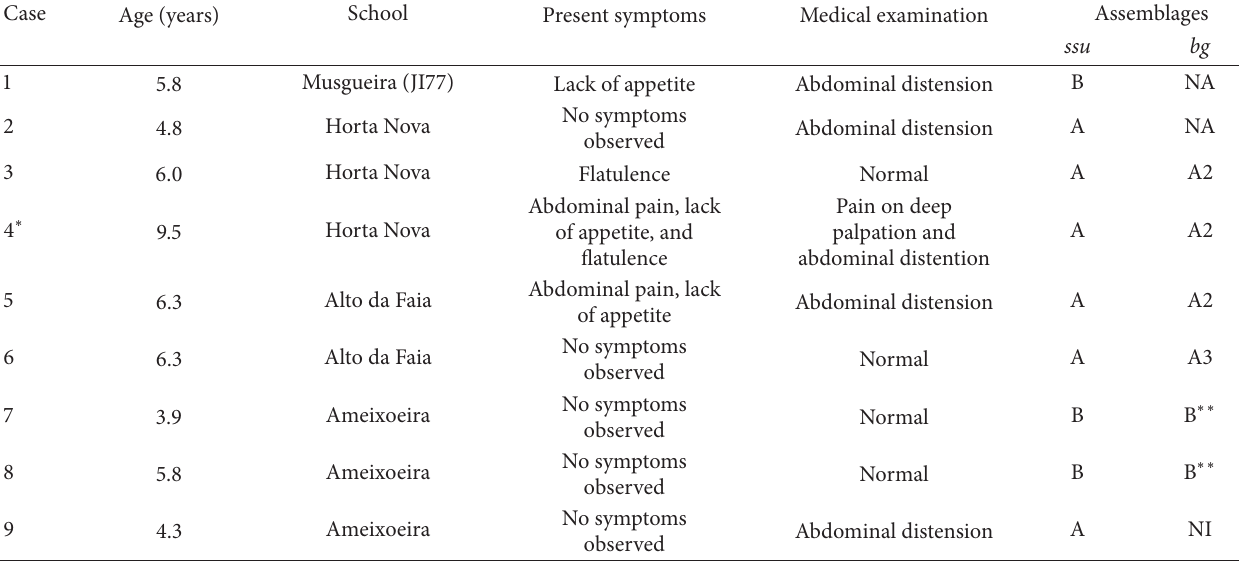
Table 1: Clinical data and G. duodenalis assemblages of the infected children.